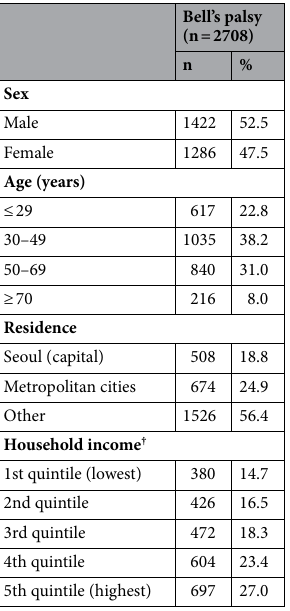
Table 2. Sociodemographic distribution of patients with Bell’s palsy. † The sum of patients in household income is less than the total due to missing